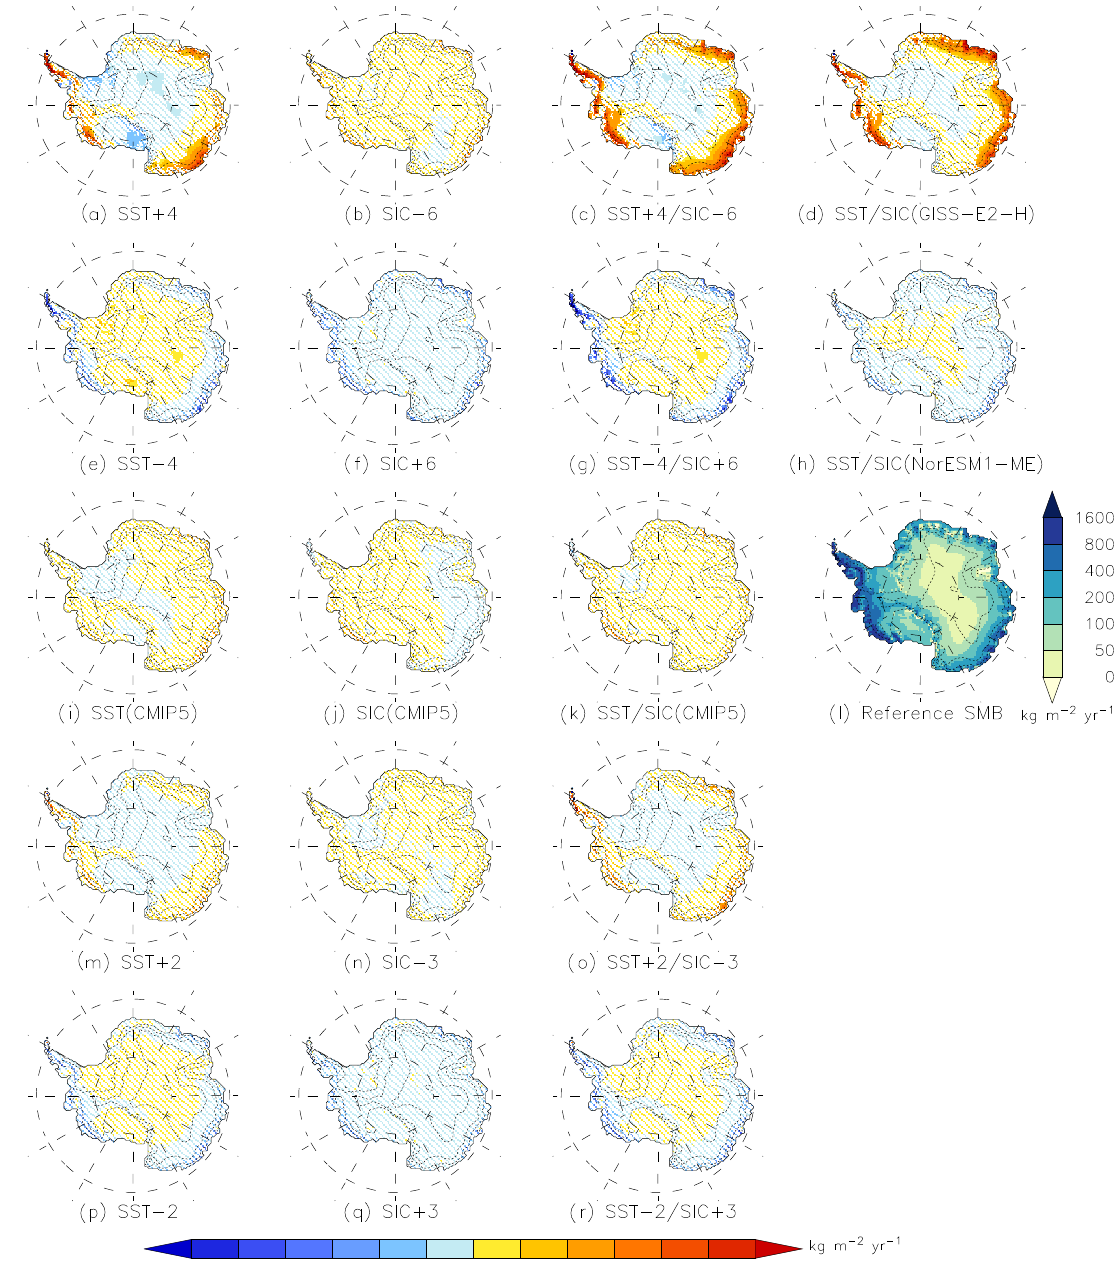
Figure 3. Difference in mean annual SMB (kgm − 2 yr − 1 ) between the reference simulation and (a) SST + 4, (b) SIC − 6, (c) SST + 4/SIC − 6, (d) SST/SIC(GISS-E2-H), (e) SST − 4, (f) SIC + 6, (g) SST − 4/SIC + 6, (h) SST/SIC(NorESM1-ME), (i) SST(CMIP5), (j) SIC(CMIP5), (k) SST/SIC(CMIP5), (m) SST + 2, (n) SIC − 3, (o) SST + 2/SIC − 3, (p) SST − 2, (q) SIC + 3, (r) SST − 2/SIC+2 experiments. Differences less than the interannual variability are considered as non-significant and are shown by dashed lines. (l) Mean annual SMB (kgm − 2 yr − 1 ) simulated by MAR forced by ERA-Interim over